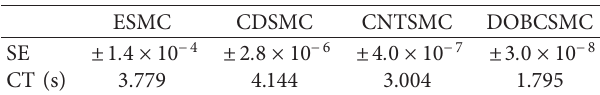
Figure 2: Simulation results of Scenario I—controlled output in steady-state phase. Table 2: Control performance of ESMC, CDSMC, CNTSMC, and DOBCSMC for Scenario